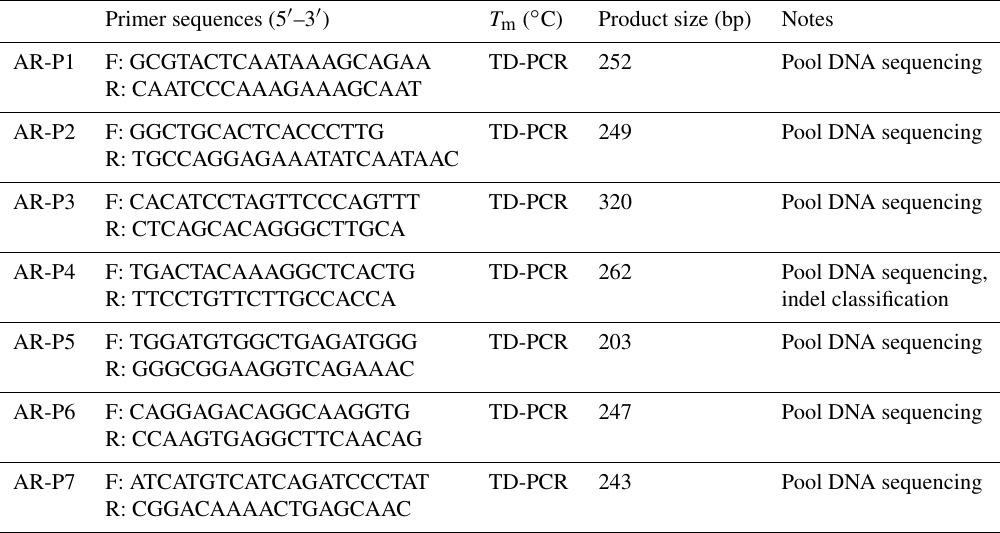
Table 1. PCR primer sequences of the cattle AR gene. Primer sequences (5 (cid:48) –3 (cid:48)